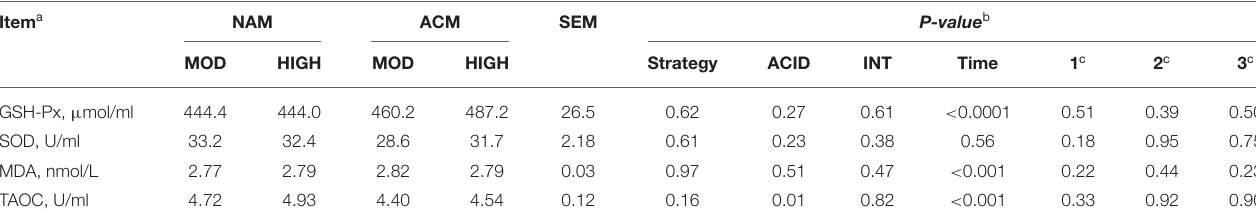
TABLE 6 | Least square means for effect of milk feeding strategy and milk acidification on oxidative biomarkers for calves fed 6 (MOD) or 12L (HIGH) of milk with (ACM) or without (NAM) acid. Item a NAM ACM SEM P-value b MOD HIGH MOD HIGH Strategy